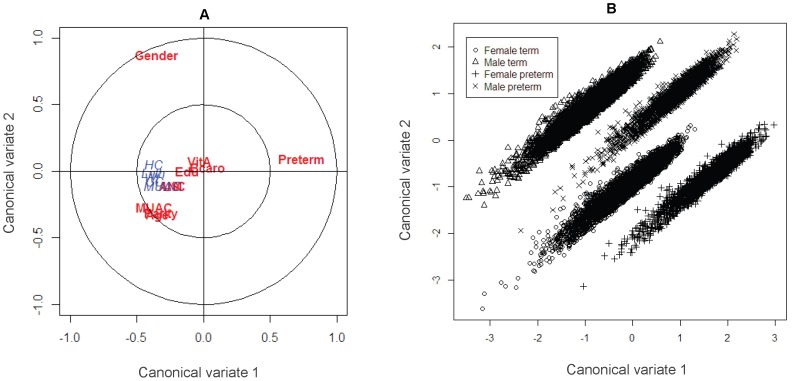
Biplot and score plot of the first two canonical functions.Panel A displays the biplot for the indicators of birth size and maternal factors with standardized weights indicated with blue and red, respectively. Panel B displays score plots for the maternal factors indicating any groupings among individuals.